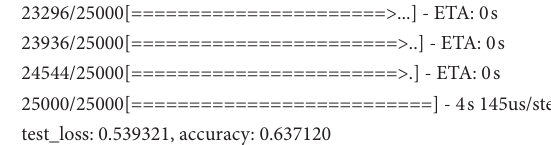
Figure 18: Average accuracy of models trained on microexpression images alone.